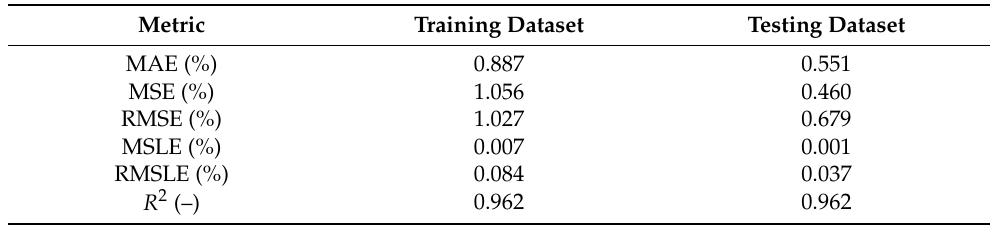
Table 7. Overall performance of the best ANN model to predict the damping ratio for both training and testing